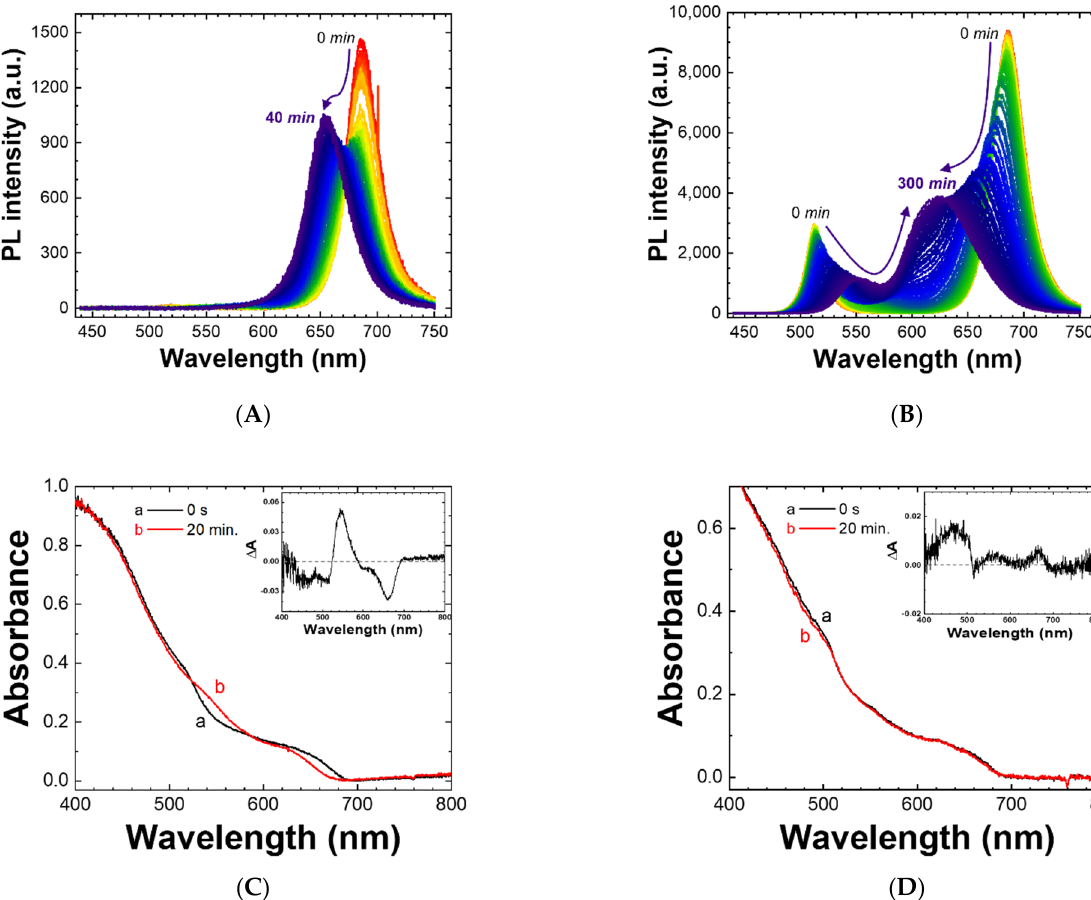
Figure 3. ( A , B ) In situ photoluminescence spectra of the halide exchange process among CsPbI 3 and CsPbBr 3 PQDs at 288 K ( A ) without PbSO 4 -oleate coverage on PQDs and ( B ) with PbSO 4 -oleate coverage on PQDs. ( C , D ) In situ absorption spectra for the halide exchange process among CsPbI 3 and CsPbBr 3 PQDs ( C ) without PbSO 4 -oleate coverage on PQDs and ( D ) with PbSO 4 -oleate coverage on PQDs. Initial absorbance (a, 0 s) and absorbance during halide exchange (b, 20 min) (inset: ∆A between a and b). Note that absorbance measurements were performed intermittently for shorter periods owing to the data collection and storage processing time required by the experimental setup.